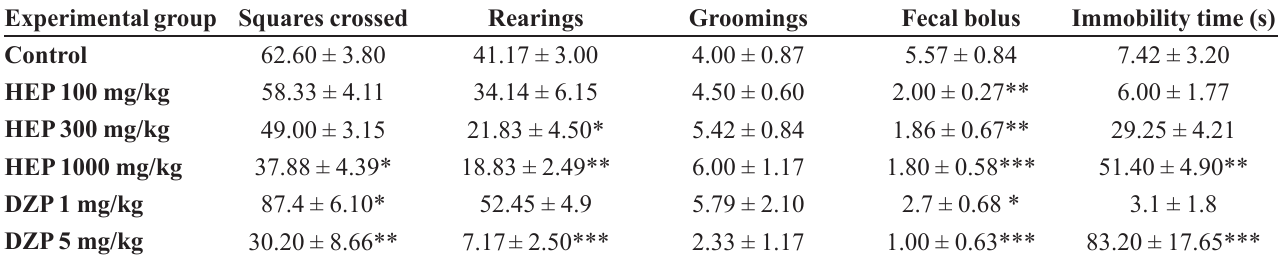
TABLE I - Effects of hydroalcoholic extract from Lafoensia pacari (HEP) on the open field test, 60 minutes after treatments Experimental group Squares crossed